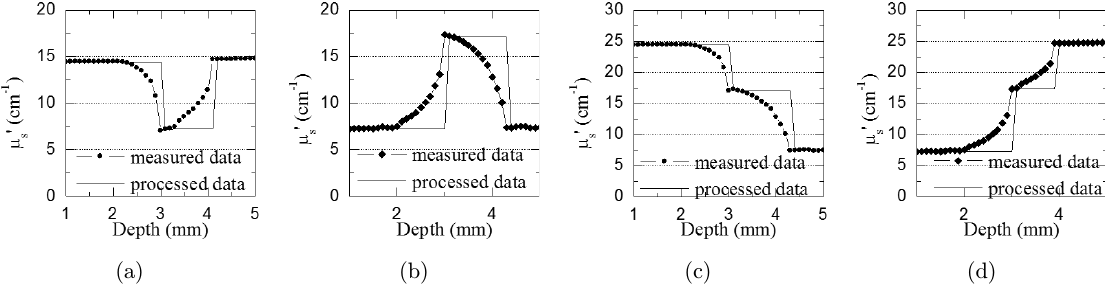
Fig. 9. The (cid:1) 0 s curves of three-layer group S (a) Sbdb model (b) Sbub model (c) Sbdd model (d) Sbuu model.